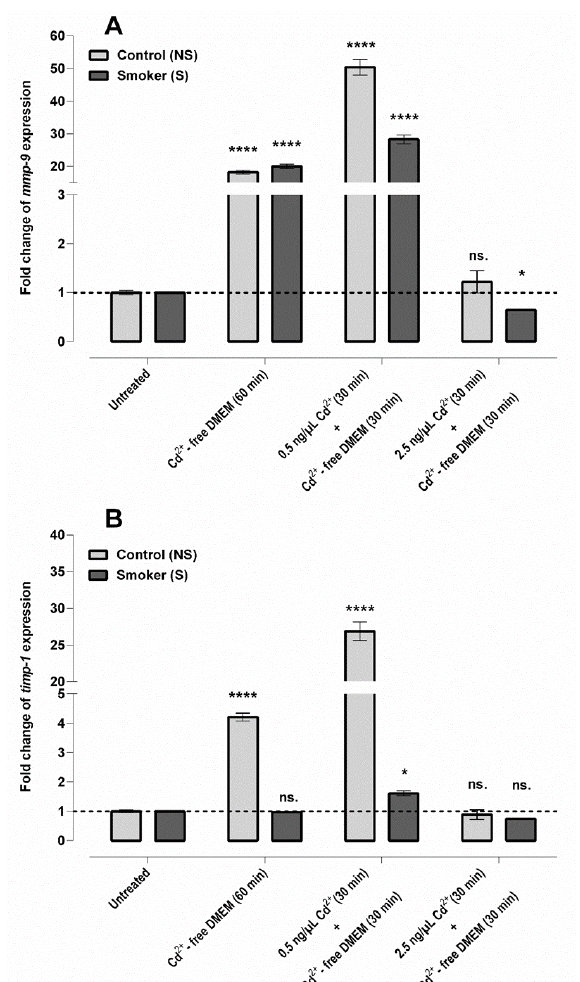
Figure 4. Stress-induced alteration in mmp-9 and timp-1 expression in an ex vivo model system: mmp-9 ( A ) and timp-1 ( B ) expression relative to untreated samples induced by heat shock and combined (heat + Cd 2+ ) stress. Number of items: control (n = 3), smoker (n = 3); all results conducted with 3 parallel reactions (mean ± SEM). Statistical analysis was conducted by using two-way ANOVA and the Holm–Sidak post hoc test (ns. = not significant; * p ≤ 0.05; **** p ≤ 0.0001).